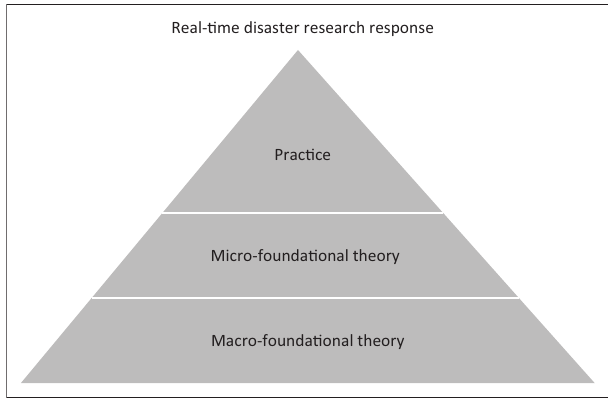
FIGURE 1: Levels of theory supporting the practice of real-time disaster response.